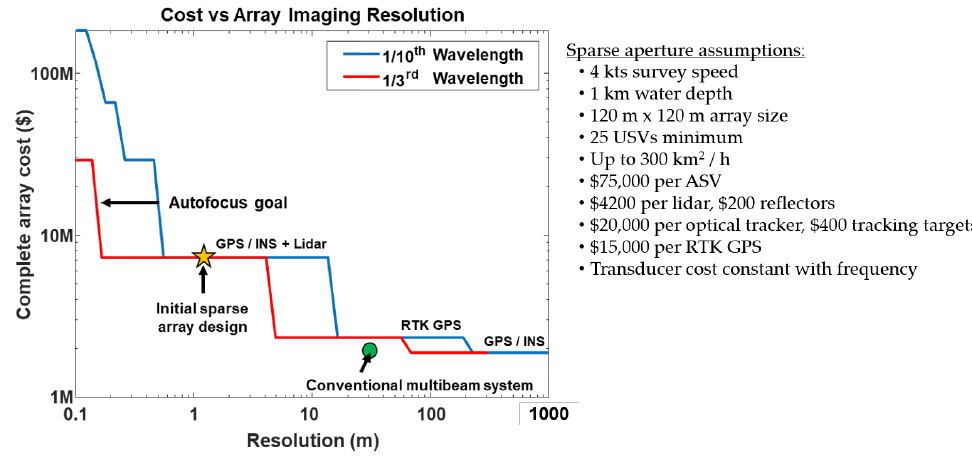
Figure 17. The potential cost of an operational sparse-aperture sonar mapping using at least 25 ASVs and our current image reconstruction, focus, and relative navigation